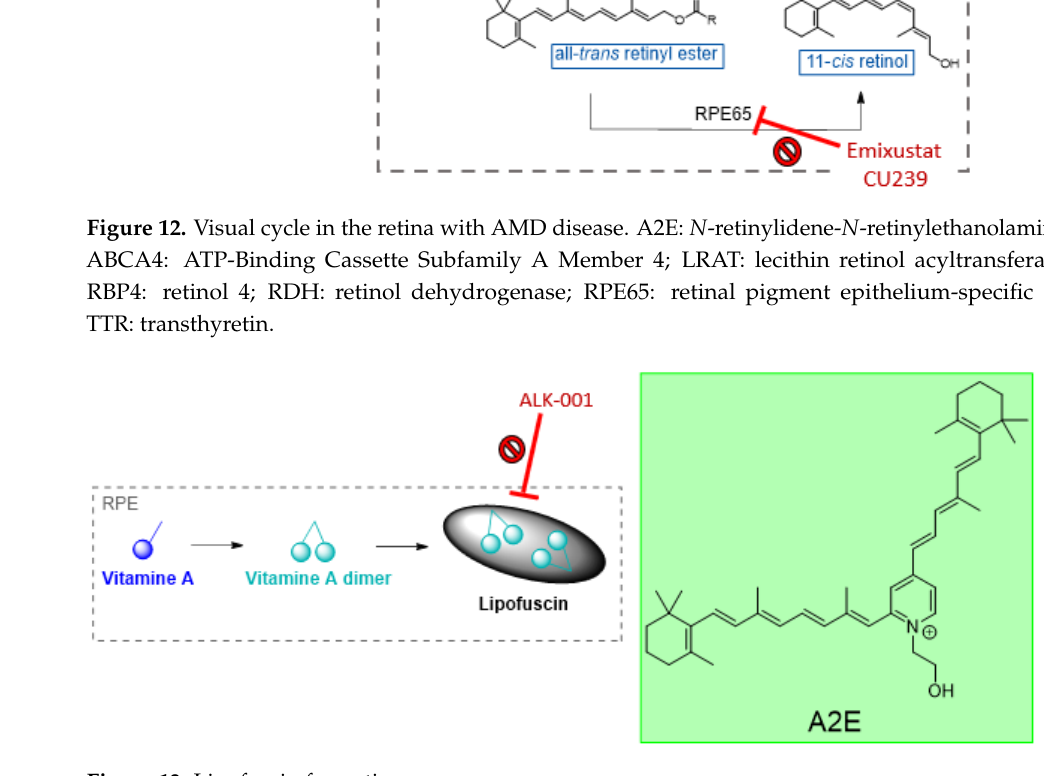
Figure 13. Lipofuscin formation.